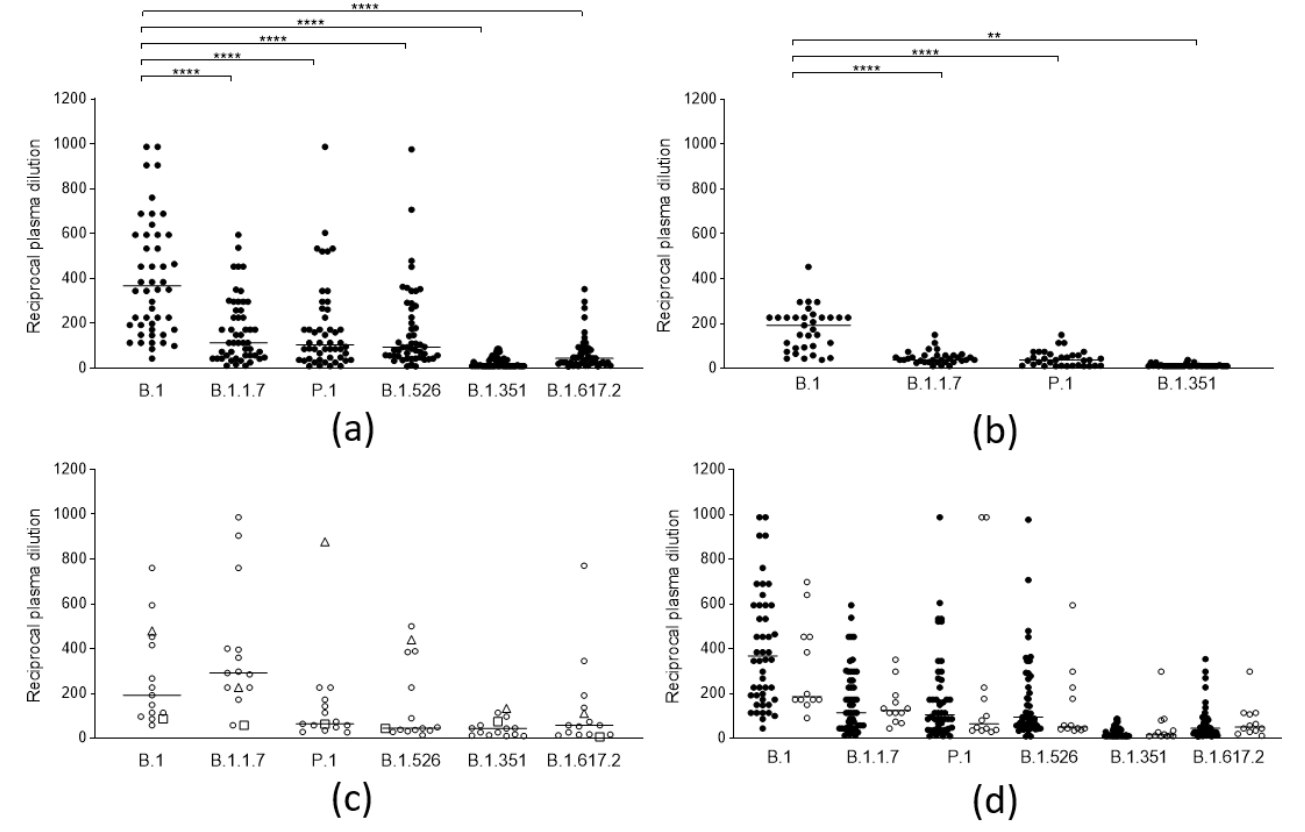
Figure 1. Neutralization activity of SARS-CoV-2 anti-spike antibodies from different groups of subjects against selected viral lineages. ( a ) Neutralization titers of vaccinees ( n = 50) 2 weeks after the second dose of the BNT162b2 vaccine against 6 viral lineages. Three data points are outside the axis limits. Statistical difference was assessed by the Wilcoxon matched pairs signed rank test. ( b ) Neutralization titers of blood donors naturally infected by the B.1 lineage ( n = 33) against 4 viral lineages. Statistical difference was assessed by the Wilcoxon matched pairs signed rank test. ( c ) Neutralization titers of blood donors naturally infected by the B.1.1.7 (white circles, n = 13), by P.1 (white triangles, n = 1), and B.1.351(white squares, n = 1) against 6 viral lineages. ( d ) Neutralization titers of subjects who became infected after a second dose of the BNT162b2 vaccine (vaccine failure, white circles, n = 12) compared to those from the general population of vaccinees (black circles, n = 50). Reductions in neutralizing titers were not statistically significant. Three data points are outside the axis limits. Statistical difference was assessed by the Mann-Whitney rank test. Neutralization titers <20 and >1280 were plotted, respectively, as 10 and 2560. Statistical significance: ns = p > 0.05, ** = p < 0.01, **** = p < 0.0001. Horizontal lines represent medians.